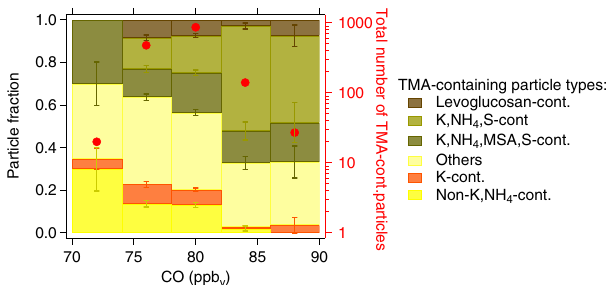
Figure 12. CO measurements compared with the cumula- tive fraction of TMA-containing particle sub-types (normal- ized to all TMA-containing particles (indicated by red dots)): “K,NH 4 ,MSA,S-containing” (dark green), “K,NH 4 ,S-containing” (light green), “K-containing” (orange), “Non-K,NH 4 -containing” (yellow), “levoglucosan-containing” (brown) and “others” (light